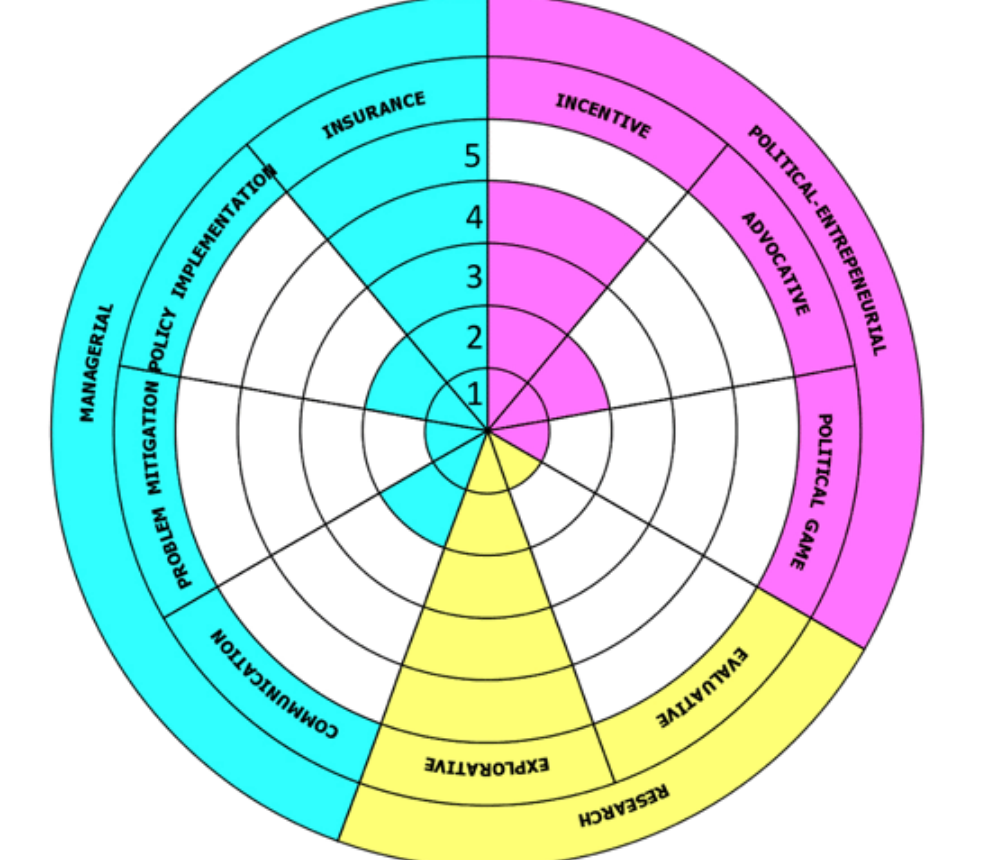
Fig. 2 . The nine uses of pilot projects within the Research, Managerial and Political-Entrepreneurial categories, depicted on a scale from 0 (absent) to 5 (strongly present) for the INSIDE pilot